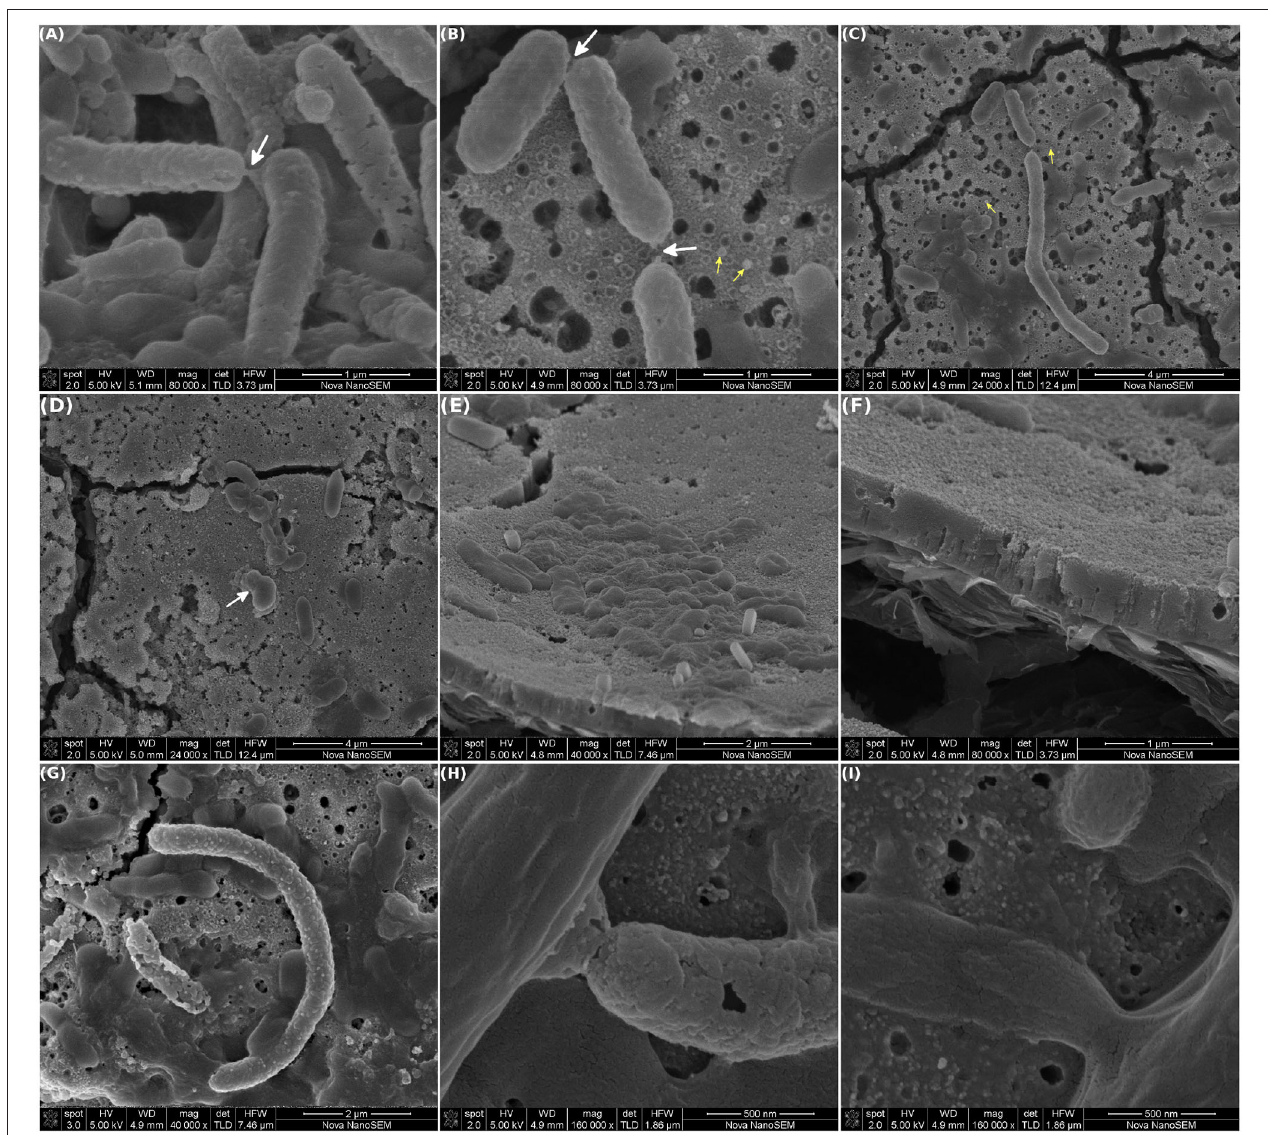
FIGURE 5 | Scanning electron microscopy of MEC-a working electrode (WE). The MEC was inoculated with the Fe-reducing microorganisms enriched from the river sediment and the WE (graphite) was initially polarized at +240 mV vs. Ag/AgCl. The MEC was operated at 30 ◦ C in anaerobiosis, other operational parameters were modified as specified in Figure 2 . At the end of the experiment (41 days) the WE was removed and observed by SEM. (A–C) Cells connected via nanotubes, white arrows (in B,C the tubes broke down during image acquisition). Yellow arrows point out at outer membrane vesicles. (D) Blebbing in an individual cell. (E) Cells over and embedded in an EPS deposit. (F) Close-up on a section of the deposit, showing the granular texture. (G,H) Biomineralized cells and (I) non-mineralized